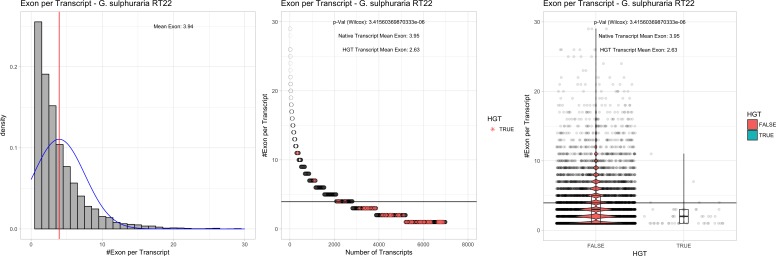
Exon/Intron – Galdieria sulphuraria RT22: (Left) Mid) Cumulative %GC distribution of transcripts.Red line shows the average, blue line a normal distribution based on the average value. The data is categorical (genes have either one, two, three etc. exons) and does not follow a normal distribution. (Mid) Ranking all transcripts based upon their number of exons. Red ‘*' demarks HGT candidates. As the number of exons was not normally distributed, transcripts were ranked by number of exons. In order to resolve the high number of tied ranks (e.g. many transcripts have two exons) a bootstrap was implied by which the rank of transcripts sharing the same number of exons was randomly assigned 1000 times. Wilcoxon-Mann-Whitney-Test applied for the determination of significant rank differences between the native gene and the HGT candidate subset. (Right) Violin plot showing the number of exons per transcript distribution across native transcripts and HGT candidates.